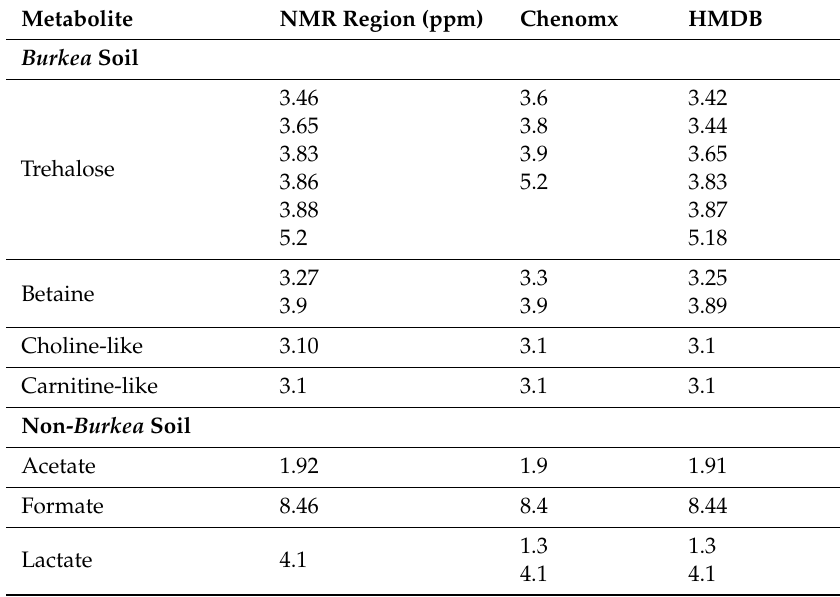
Table 2. Annotated compounds showing NMR regions found in Burkea soils versus non-Burkea top and subsoils compared to Chenomx and Human Metabolome database